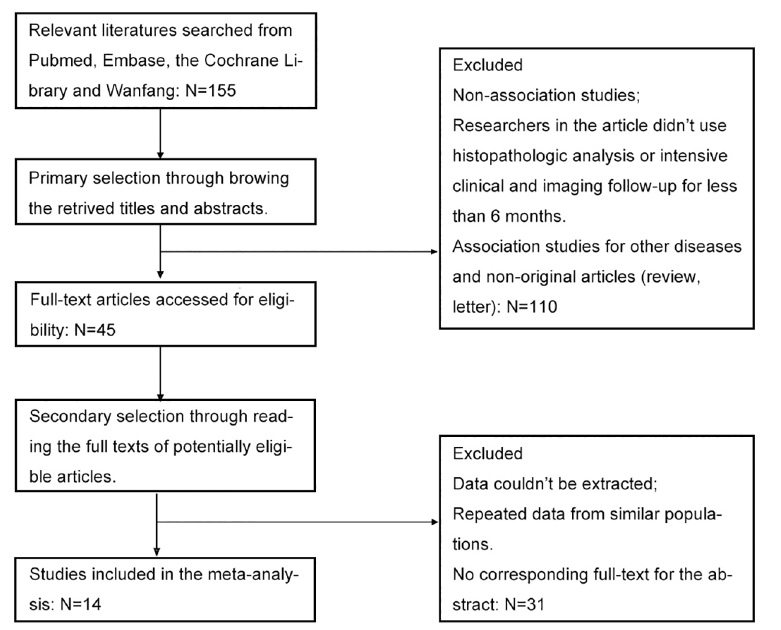
Fig 1. Flow-chart for identification of eligible